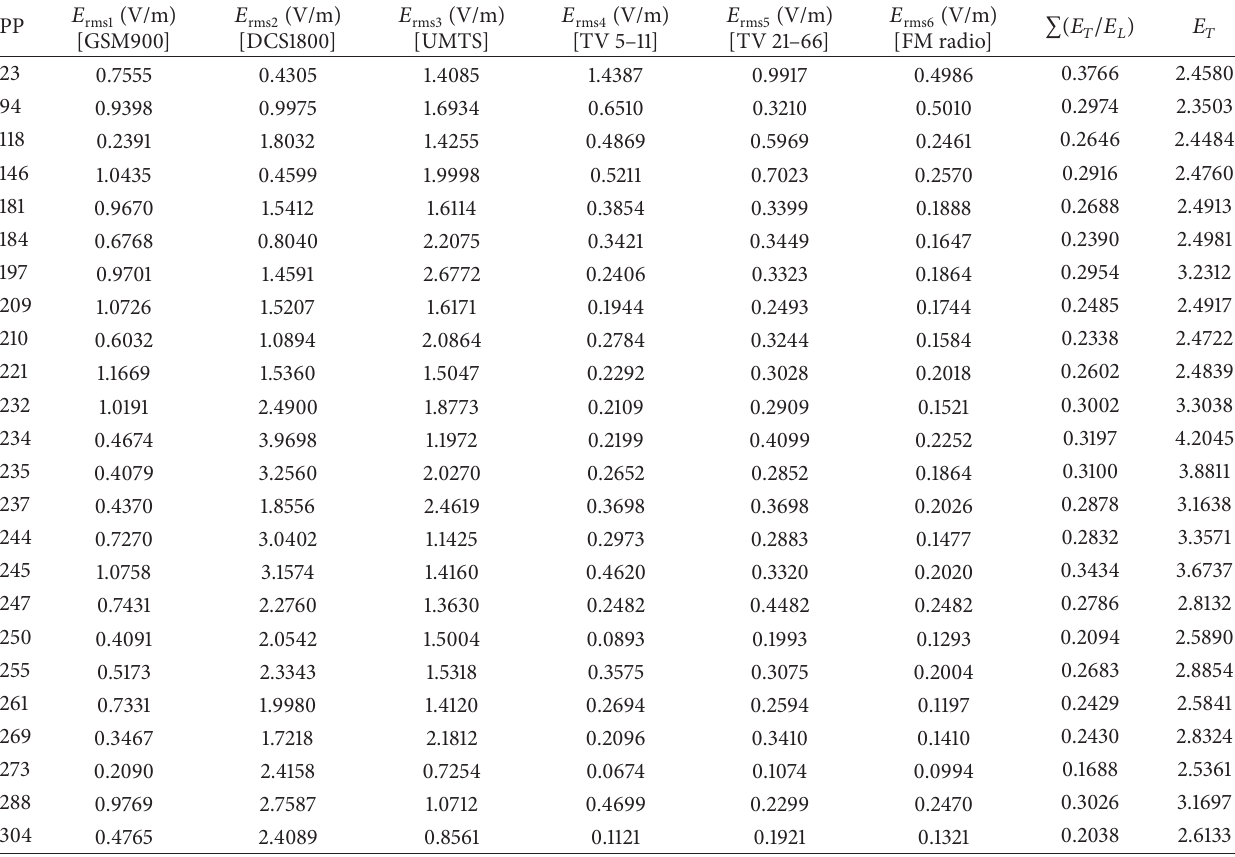
Table 2: Software prediction of total electric field strength at 24 points with maximum values.